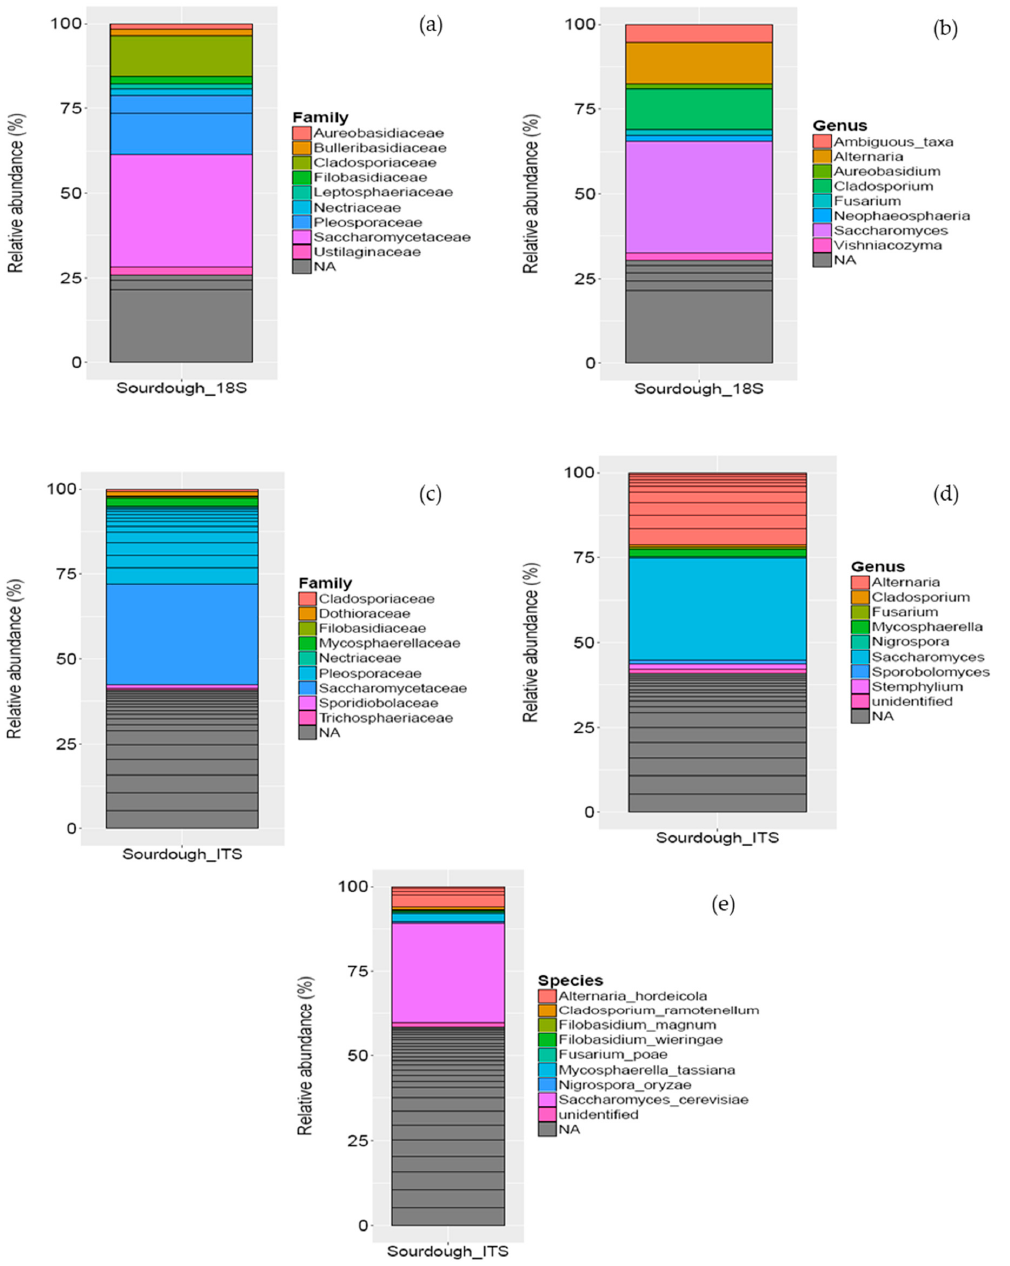
Figure 3. Analysis of the eukaryotic community in sourdough by sequencing the 18S rRNA gene ( a ) distribution of the major fungal families, ( b ) distribution of the major fungal genera. ( c ) Analysis of eukaryotic community in sourdough by sequencing the ITS gene. Distribution of the major fungal families, ( d ) distribution of the major eukaryotic genera, and ( e ) distribution of the major eukaryotic species. The scale in the y-axis reflects the normalized relative abundance percentages (%). Black lines within each bar separates each species into lower taxonomic levels.